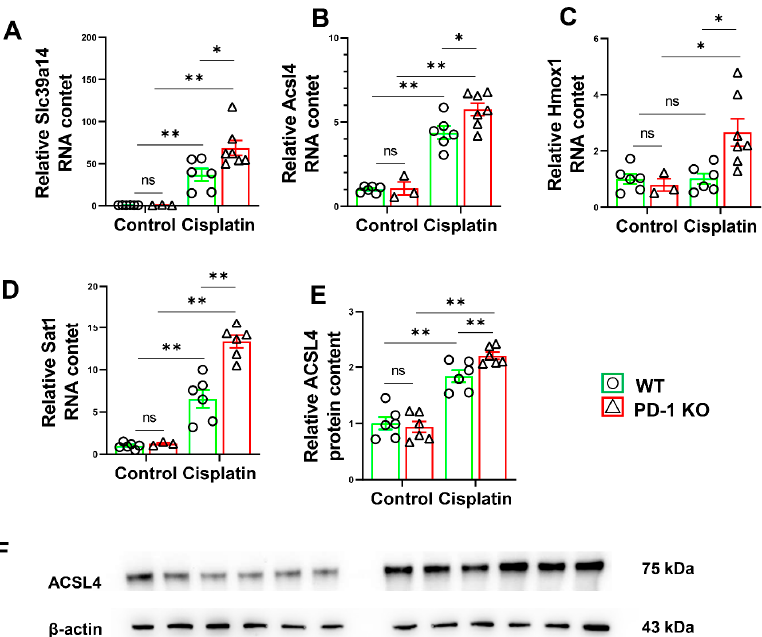
Figure 7. PD-1 − / − exacerbated muscle ferroptosis in mice after cisplatin treatment. ( A ) The relative mRNA levels of Slc39a14 in skeletal muscle. ( B ) The relative mRNA levels of Acsl4 in skeletal muscle. ( C ) The relative mRNA levels of Hmox1 in skeletal muscle. ( D ) The relative mRNA levels of Sat1 in skeletal muscle. ( E ) The relative protein levels of Acsl4 in skeletal muscle. (F) The representative protein bands of Acsl4 and β -actin in skeletal muscle. n = 5–6 per group. * p < 0.05; ** p < 0.01; ns: non-significant. all values are mean ± SEM.